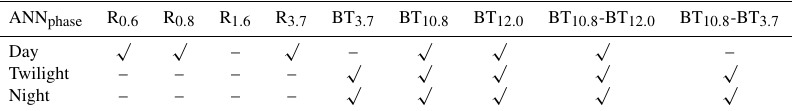
Table B3. Measurement input to the trained artificial neural network for cloud phase determination (ANN phase ), used for different illumina- tion conditions: daytime, twilight and night-time. The subscript in the table’s headline corresponds to the approximate central wavelength of the channels: 0.6, 0.8, 1.6, 3.7, 10.8 and 12.0µm. In addition to the measurement input, all ANNs require a surface type flag containing the values 0 (sea), 1 (land), 2 (desert), 3 (sea ice) and 4 (snow).